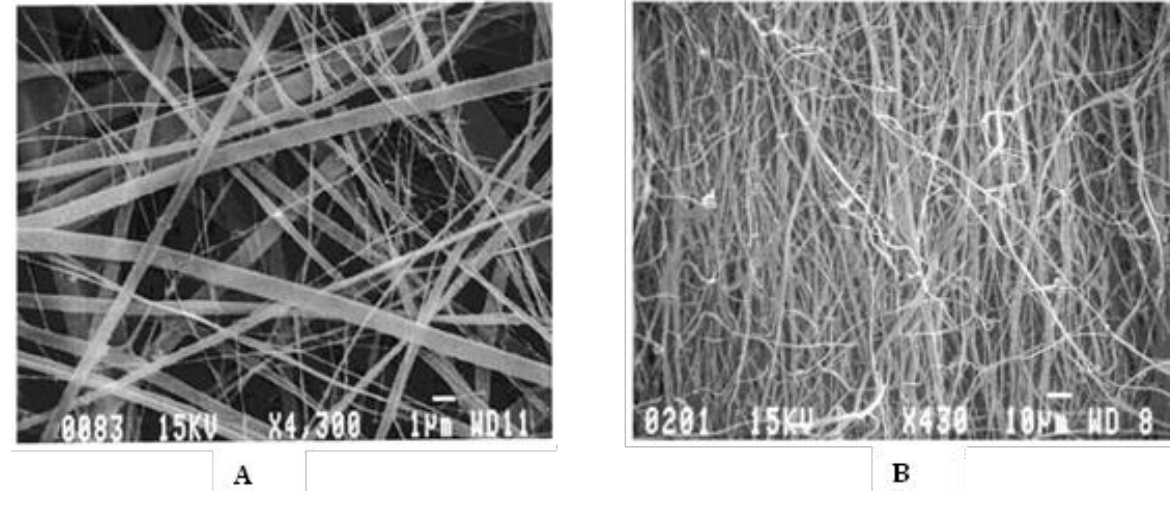
Figure 9. SEMs of electrospun collagen [157]. ( A ) Randomly oriented fibrils generated at less than 500 rpm. ( B ) Aligned fibrils generated at 4500 rpm. Reprinted and adapted with permission from [157]. Copyright 2002, American Chemical Society.